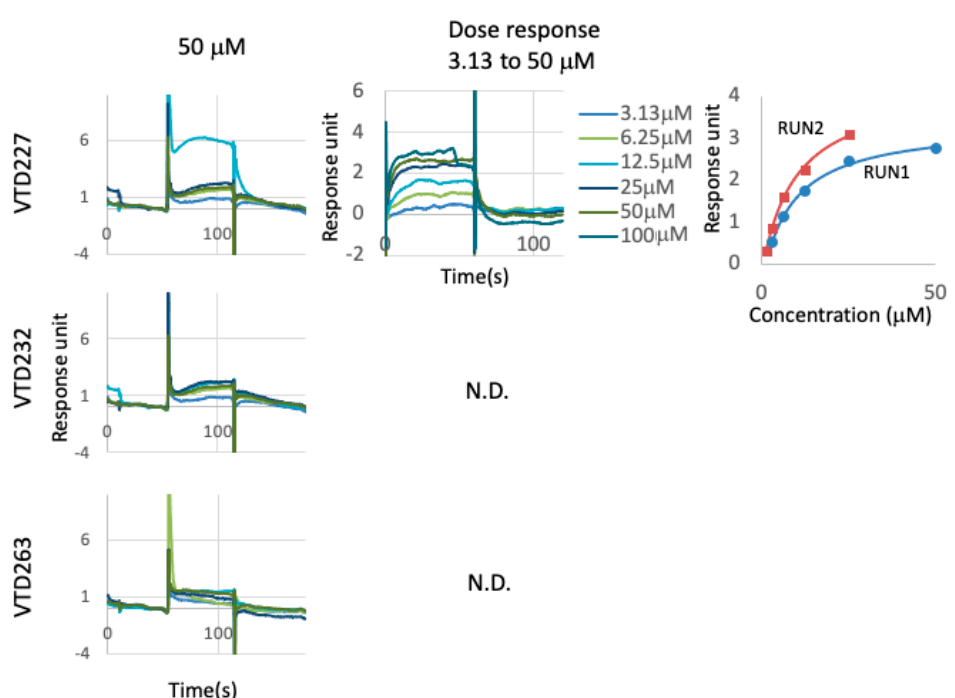
Figure 5. The binding affinity to the Vpr protein of the final selected compounds. To analyze whether the compounds directly bind to the HIV Vpr protein, the binding affinity of the compounds with a purified GST-Vpr protein was assessed by Biacore. GST-Vpr immobilized on the sensor CM5 chips and flew analyte as 50 μ M of the compounds, VTD227, VTD232, and VTD263 (( Left ) panel), and as a dose from 3.13 to 100 μ M of the compound, VTD227 (( Center ) panel). This dissociation constant (Kd) value was calculated by two independent experiments using equilibration analysis (( Right ) panel), as shown in Table 2. N.D. means as not determined.